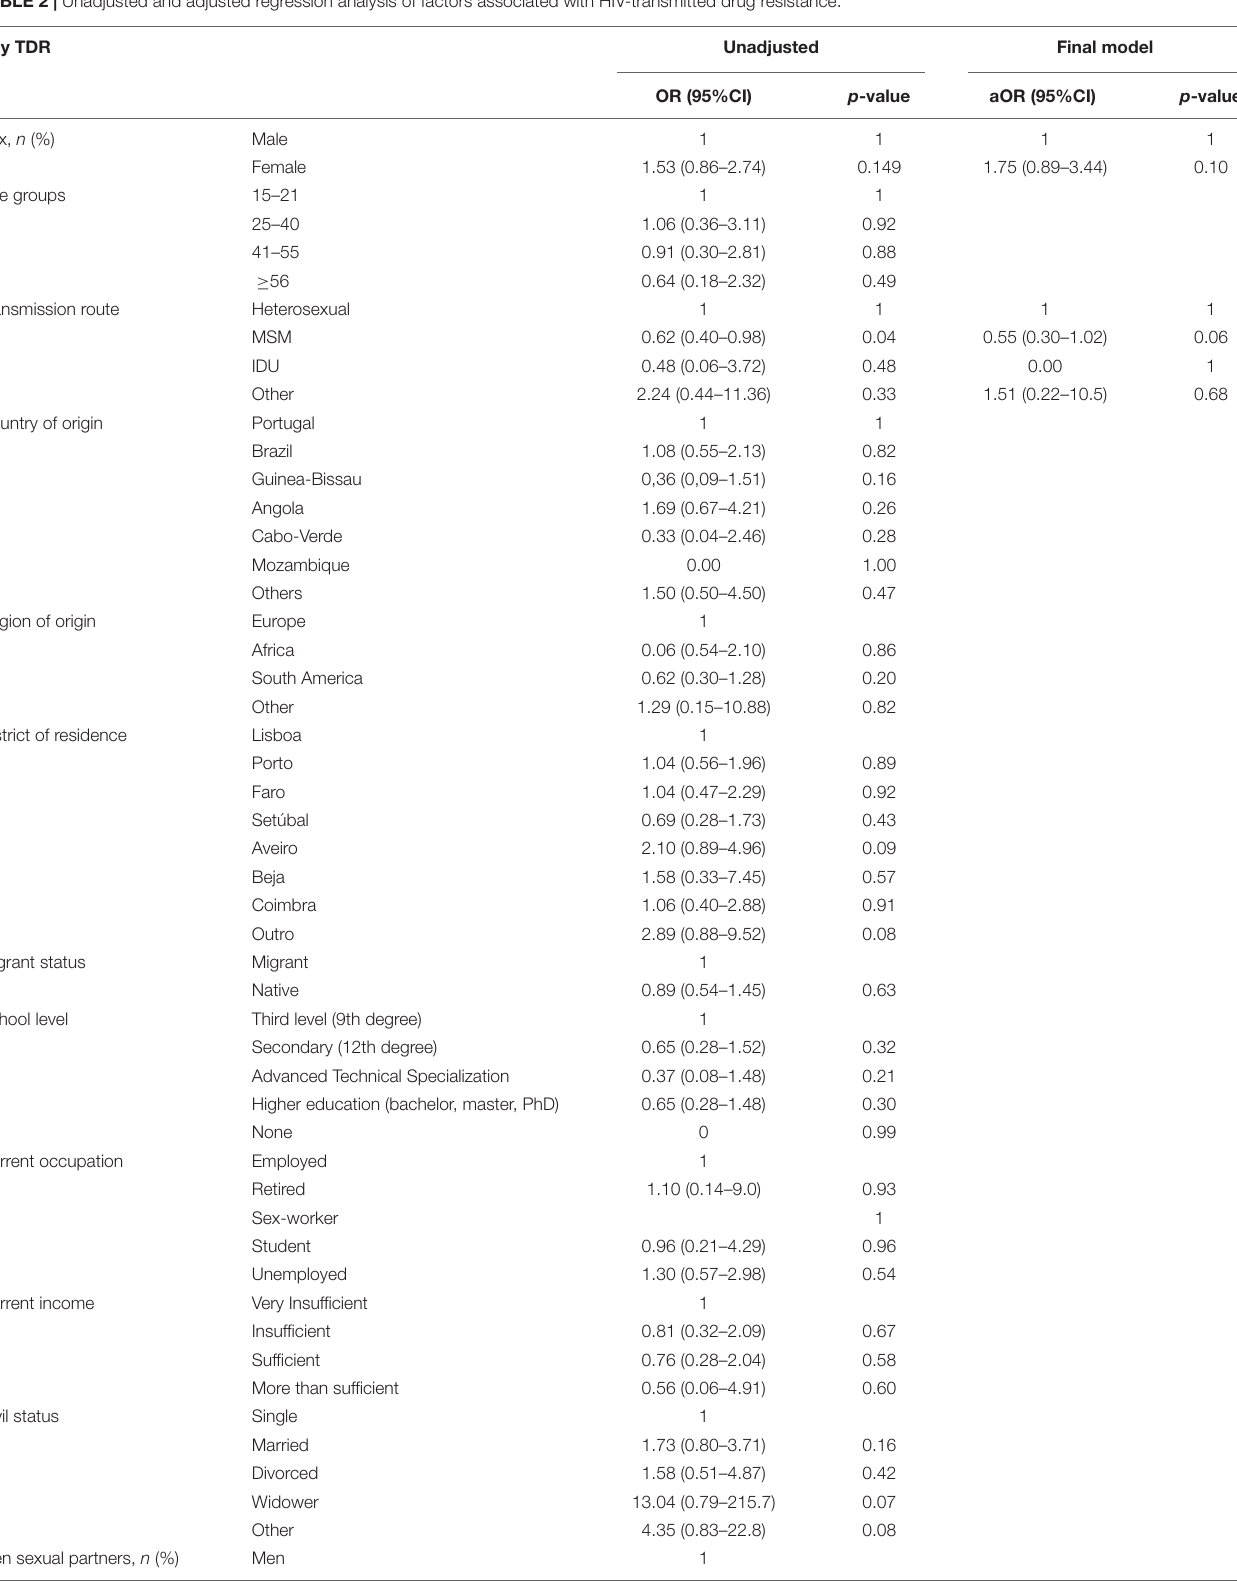
TABLE 2 | Unadjusted and adjusted regression analysis of factors associated with HIV-transmitted drug resistance. Any